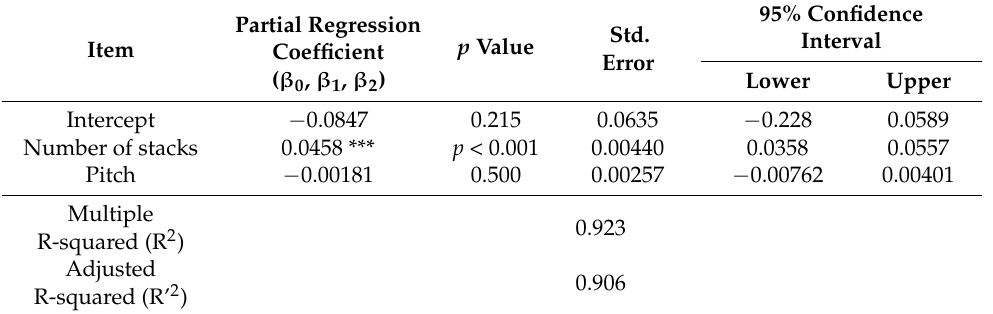
Table 7. Multiple regression analysis results using all results